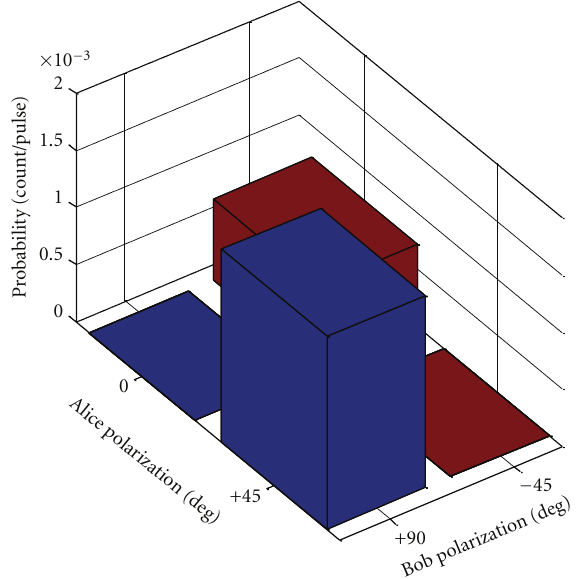
Figure 14: Relation between the preparation basis and measure- ment outcomes measured by Alice and Bob for randomly selected polarizations with the error correction.